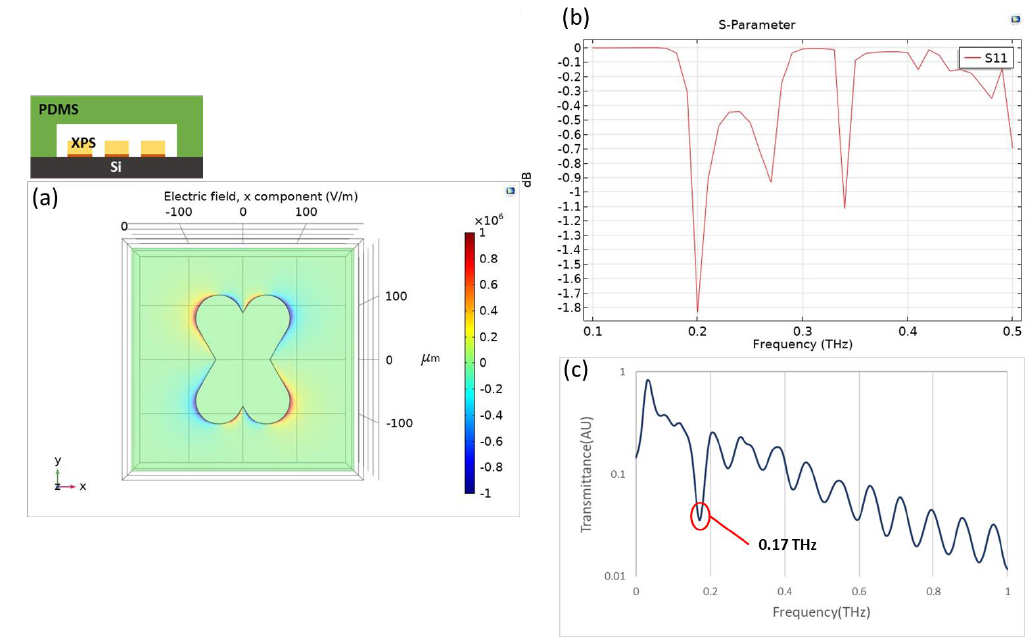
Figure 5. Simulation for microfluidic cartridge. ( a ) X-component of electric field distribution in a quadrupole resonance. ( b ) A simulation result shows a resonant dip at 0.20 THz. ( c ) An experimental result shows a resonant dip at 0.17 THz.